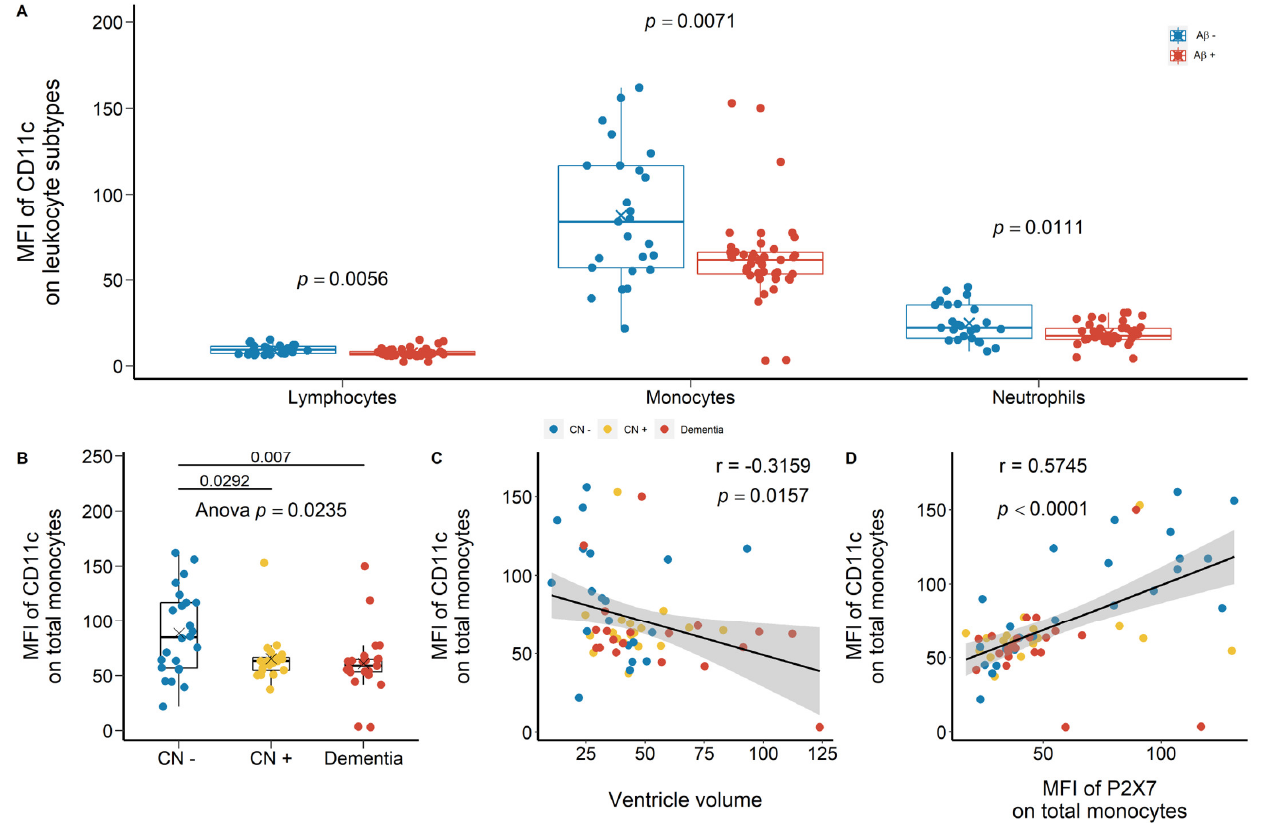
Figure 8. CD11c expressions on peripheral leukocytes in the discovery cohort. ( A ) CD11c expressions on total lymphocytes ( left ), total monocytes ( middle ), and total neutrophils ( right ) between Aβ −ve controls (Aβ−) and Aβ +ve cases (Aβ+). Bar graphs illustrated the boxplot distribution of individual measurements with “x” denoting the mean. Two group comparison was determined by t -test. ( B ) CD11c expressions on total monocytes between CN (CN−: CN −ve), pre-clinical (CN+: CN +ve), and AD with dementia individuals (Dementia: MCI +ve and AD). Bar graphs illustrated the boxplot distribution of individual measurements with “x” denoting the mean. Three-group comparison was determined by one-way ANOVA followed by multiple comparison using Dunnett’s post-hoc test (solid line). ( C ) The association between monocyte CD11c expression and ventricle volume. ( D ) The association between monocyte CD11c expression and P2X7 expression. Correlation r and p values were calculated by Pearson product-moment correlational analysis. The “grey” band indicated the 95% confidence interval of the black linear regression line.